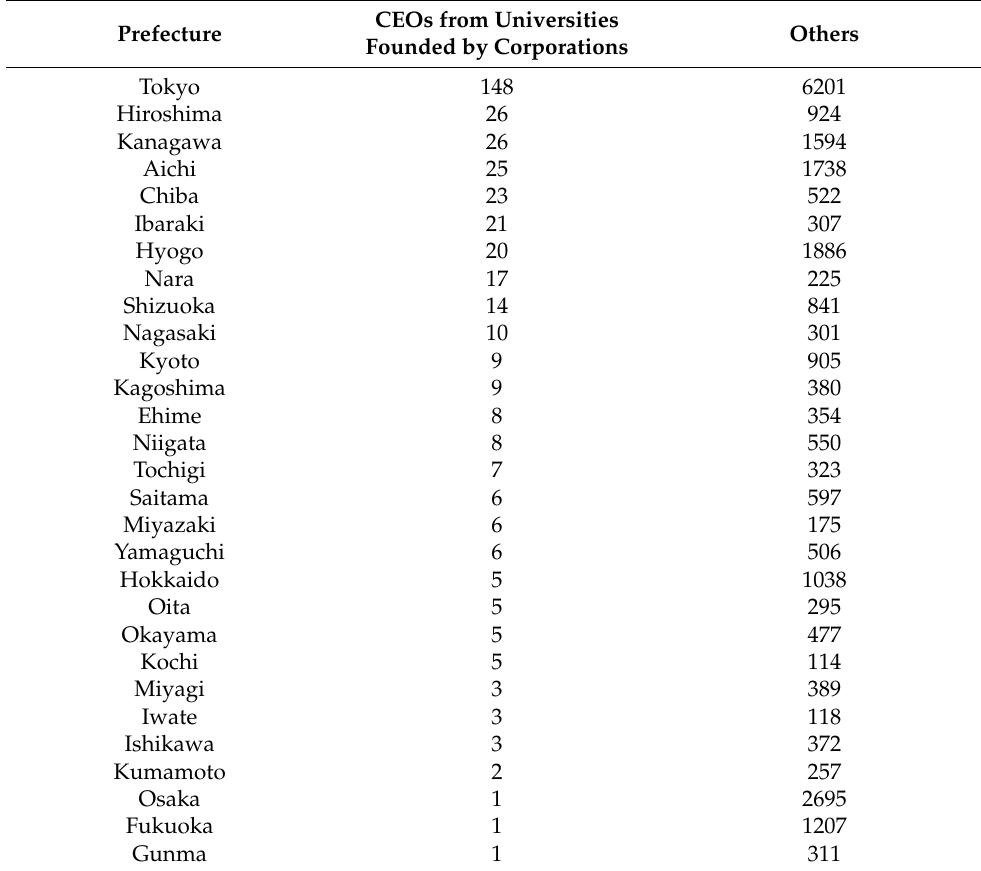
Table A5. Birthplace